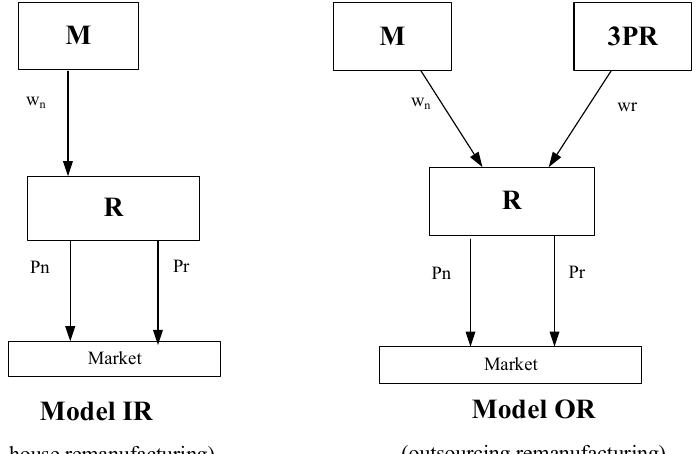
Figure 1. Supply chain structures.